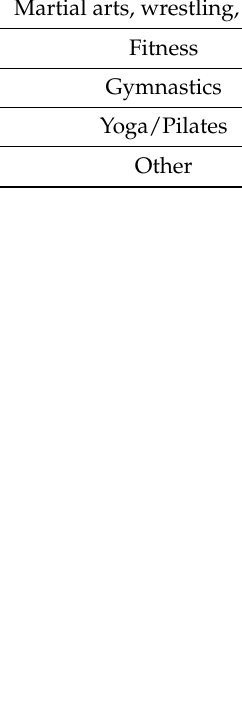
Table 5. Sports in addition to weightlifting by age and